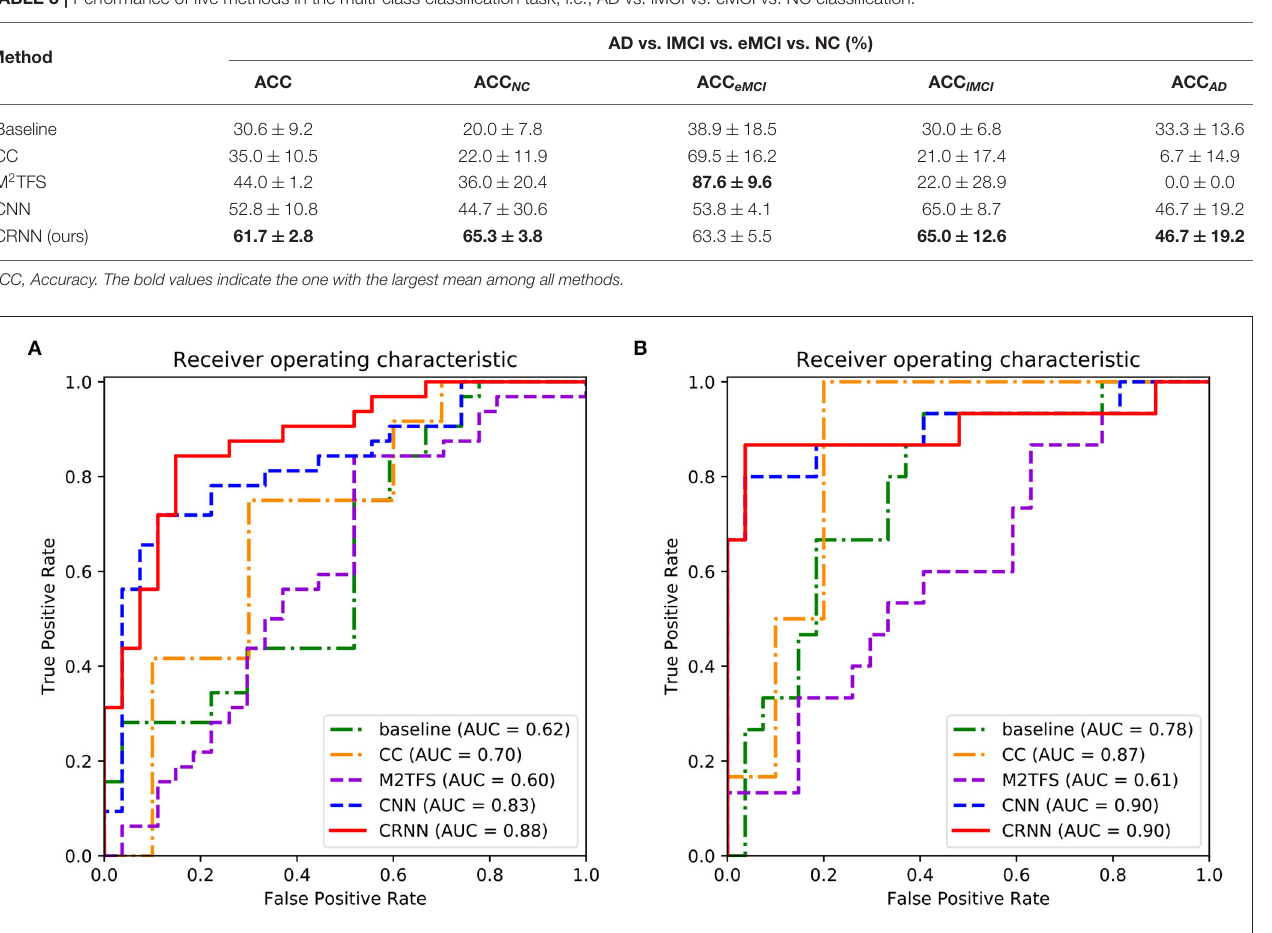
FIGURE 2 | Receiver operating characteristic (ROC) curves achieved by five different methods in (A) eMCI vs. NC classification and (B) AD vs. NC